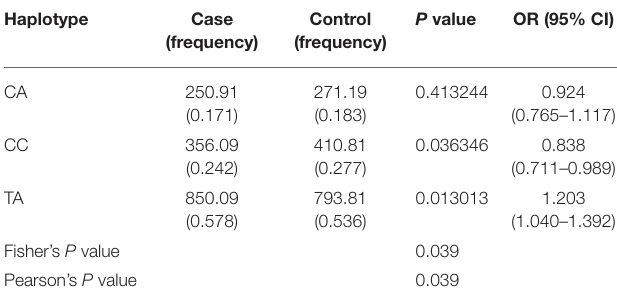
TABLE 3 | Haplotype analysis of rs11805303 and rs10889677 SNPs.